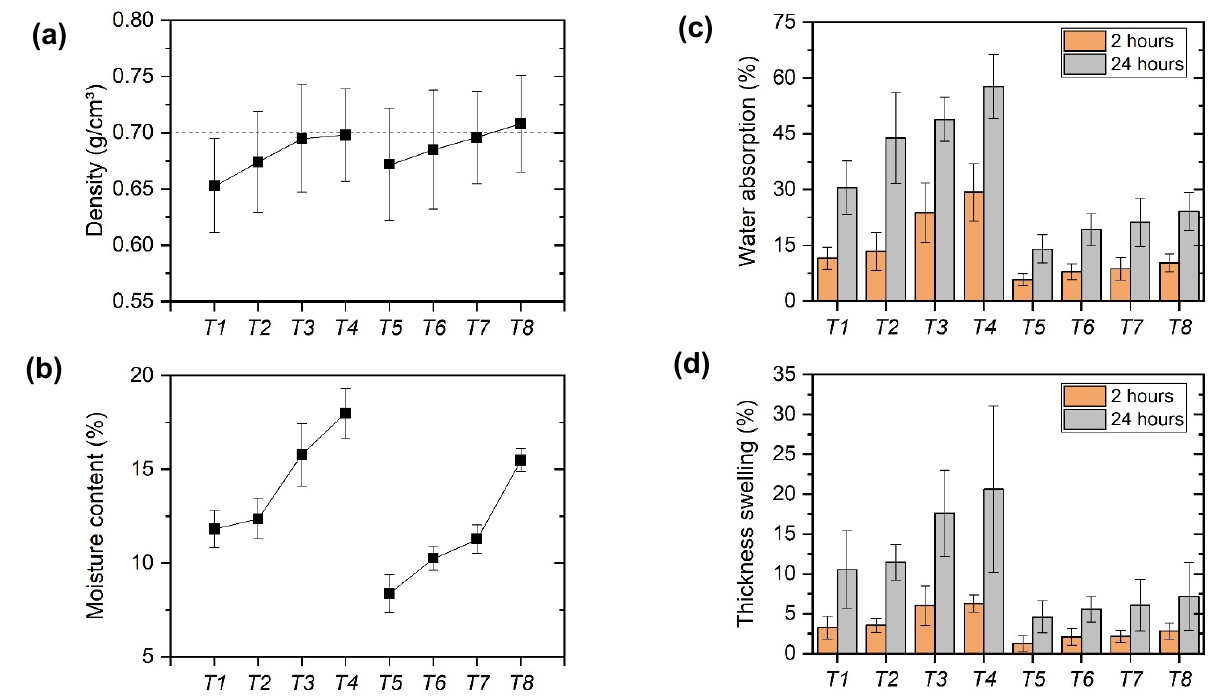
Figure 4. Graphs of physical properties analyzed. ( a ) density, ( b ) moisture content, ( c ) water absorption, and ( d ) thickness swelling.